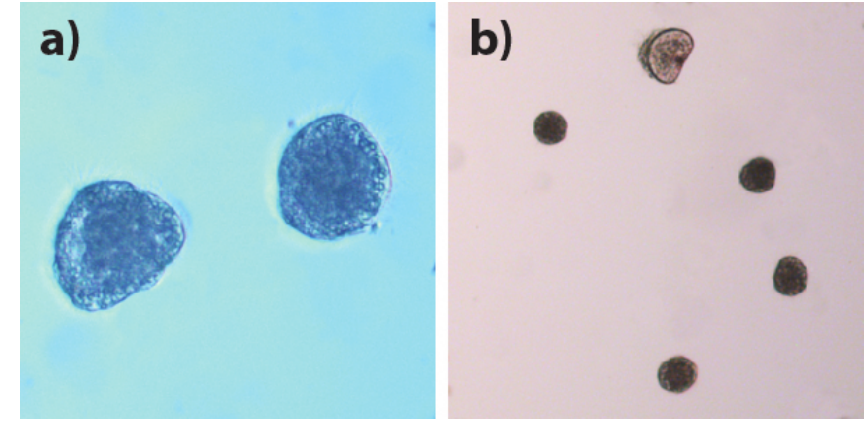
survival rate. Sizes of 50 larvae from each cylinder were measured along the longest axis. Mean values from each cylinder were used as statistical replicates. Figure 1. Mytilus galloprovincialis larvae from the end of the experiment [58 h after fertilization (a.f.)]. (a) Late trochophore stage larvae incubated at control conditions ( p CO = 380 ppm, T = 16 ◦ C) showing the univalved shell; (b) The occasional early 2 D-veliger larva with a bivalved shell among the majority of late